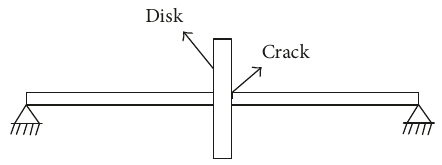
Figure 1: Schematic of the cracked rotor.